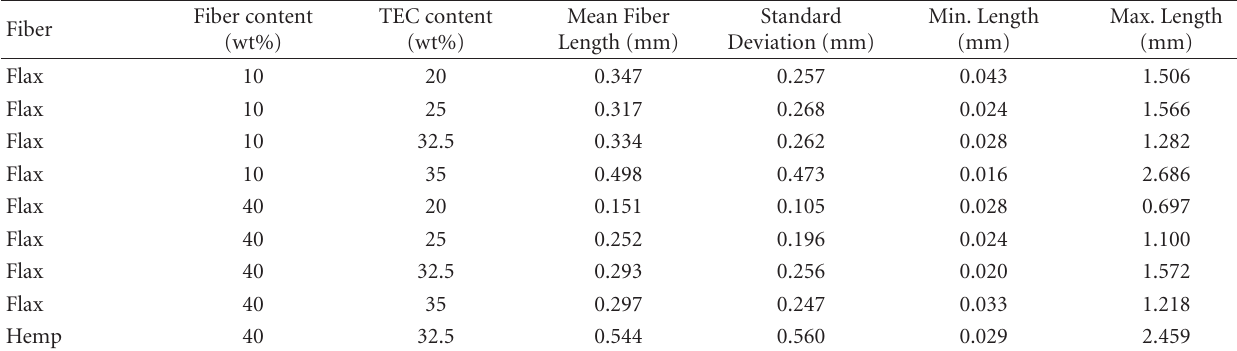
Table 1: Mean fiber lengths, standard deviations, minimum and maximum lengths of the fully processed flax, and hemp fibers in the composites.